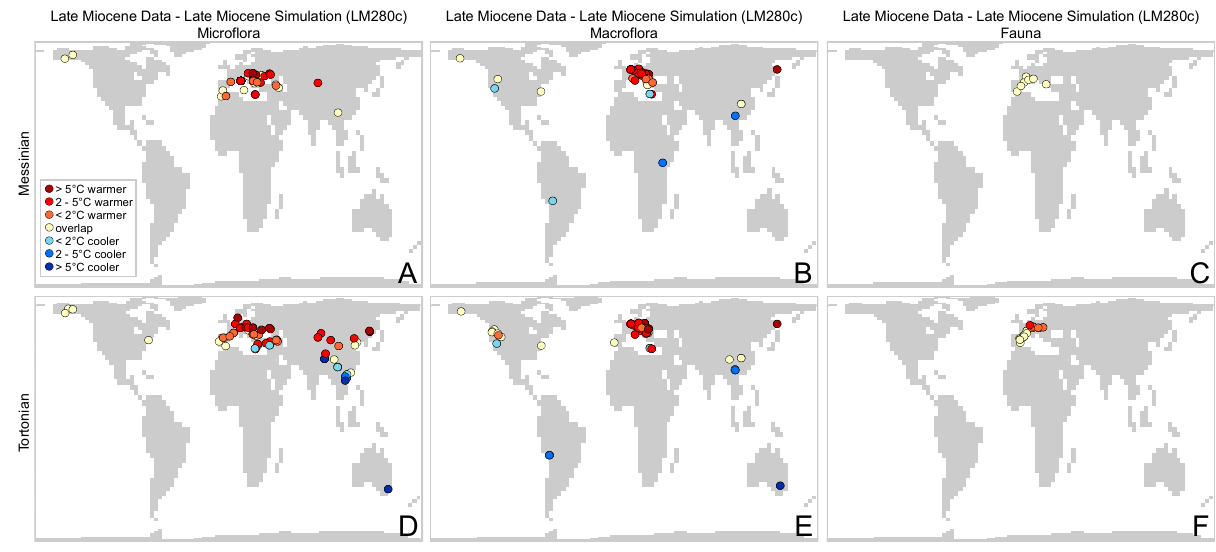
Fig. 8. Results from the model–data comparison for mean annual temperature, late Miocene data (LM280c).